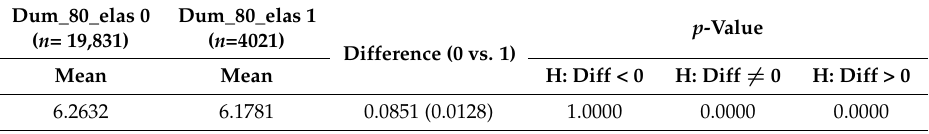
Table 7. Difference test of means in logarithm of hourly consumption by Dum_80_elas variable. Dum_80_elas 0 ( n =